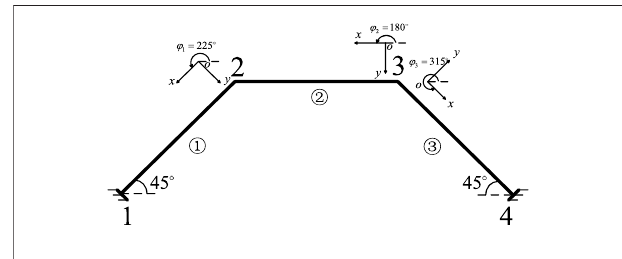
FIGURE 6 | Node coding (point j to point i ).